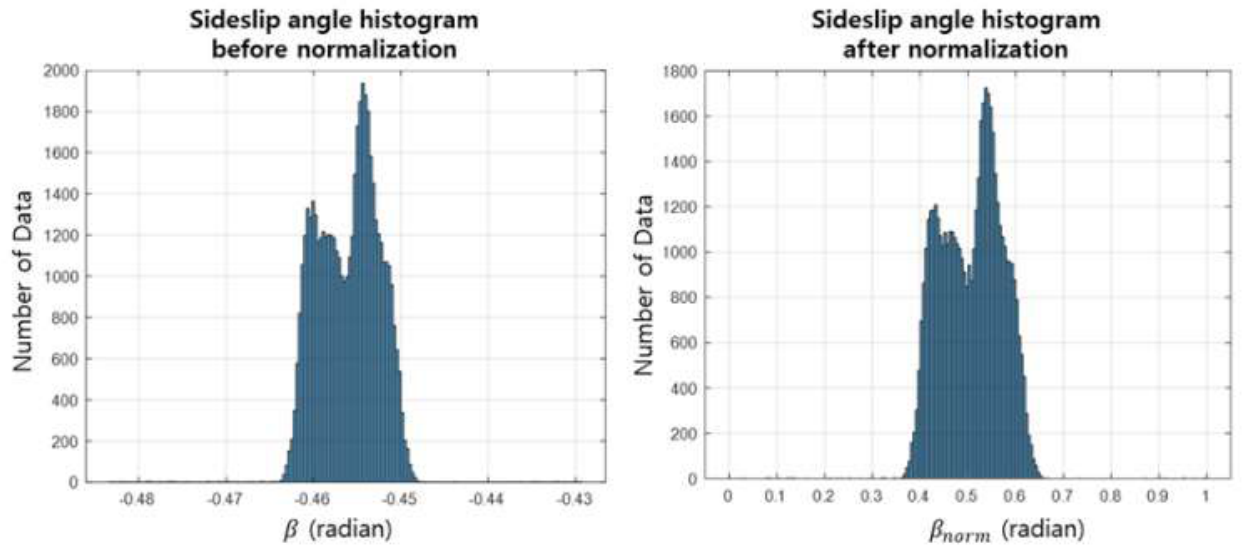
Figure 14. Neural-network-based drift control system. 5.2.1. Deep Neural-Network-Based Controller for Steering Control A typical NN comprises an input layer, one or more hidden layers, and an output layer. To include the characteristics of the system and prevent unstable behavior due to external disturbances [26,27], the present study employed a DNN with six hidden layers. Each of the six hidden layers was configured with 20 artificial neural nodes as shown in